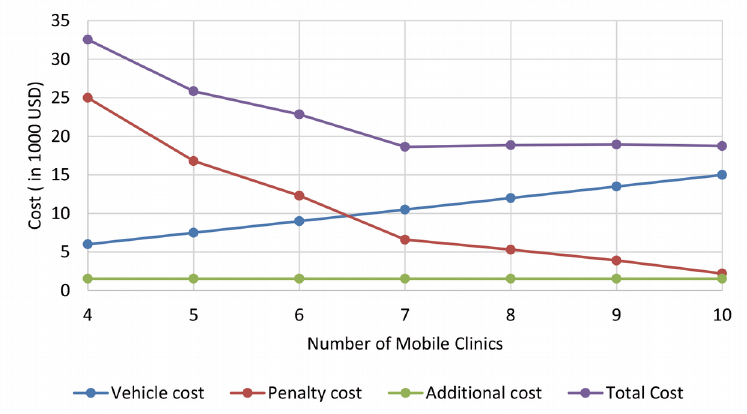
Figure 2. Relationship between the number of mobile clinics dispatched to vehicle cost, penalty cost due to unmet patients, and total